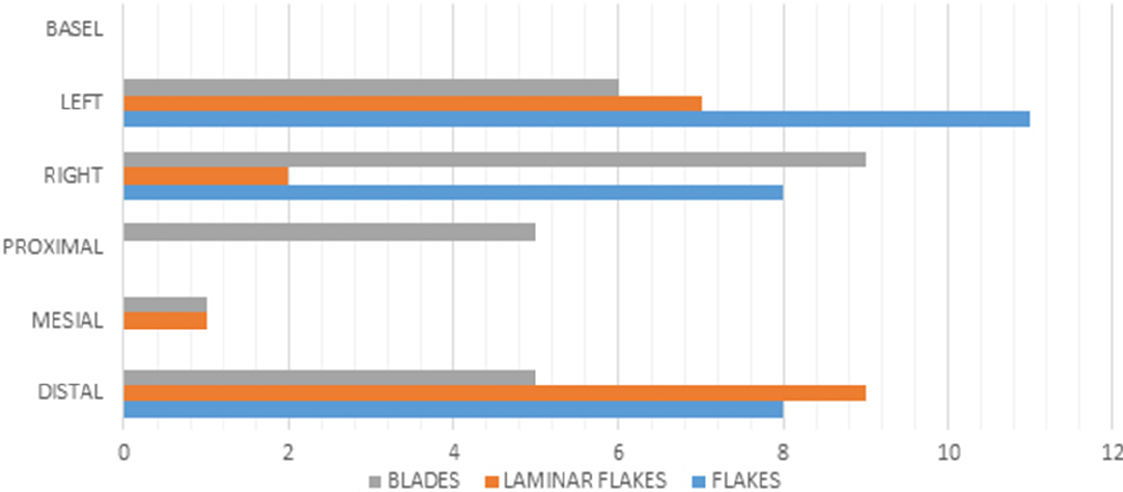
Figure 7. Location of the